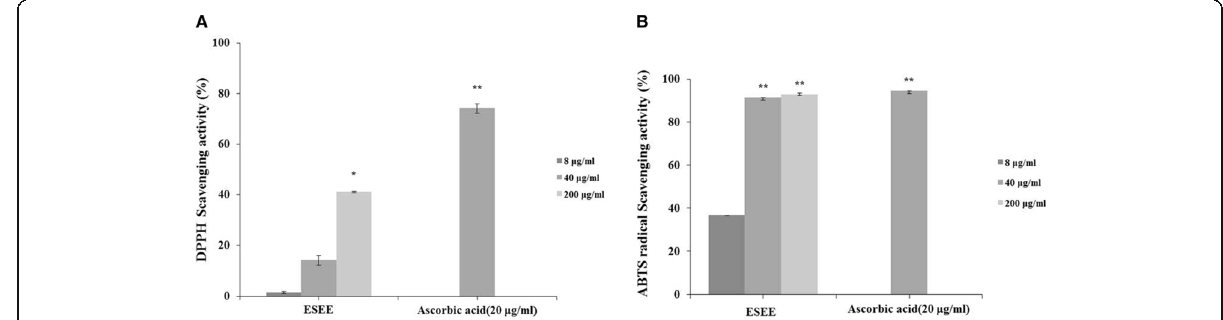
Fig. 2 Antioxidant activities of ES extract. a Scavenging effect of ES on DPPH radical ( b ) ABTS + radical scavenging activity of the extract. The ES ethanol extract (ESEE) (8, 40, 200 μ g/ml), ascorbic acid (20 μ g/ml) were incubated with DPPH, ABTS + solution, respectively. Results are represented as percentages of control, and the data represent mean ± S.D. for three separate experiments. Values are significantly different by comparison with control. *: p < 0.05, **: p <